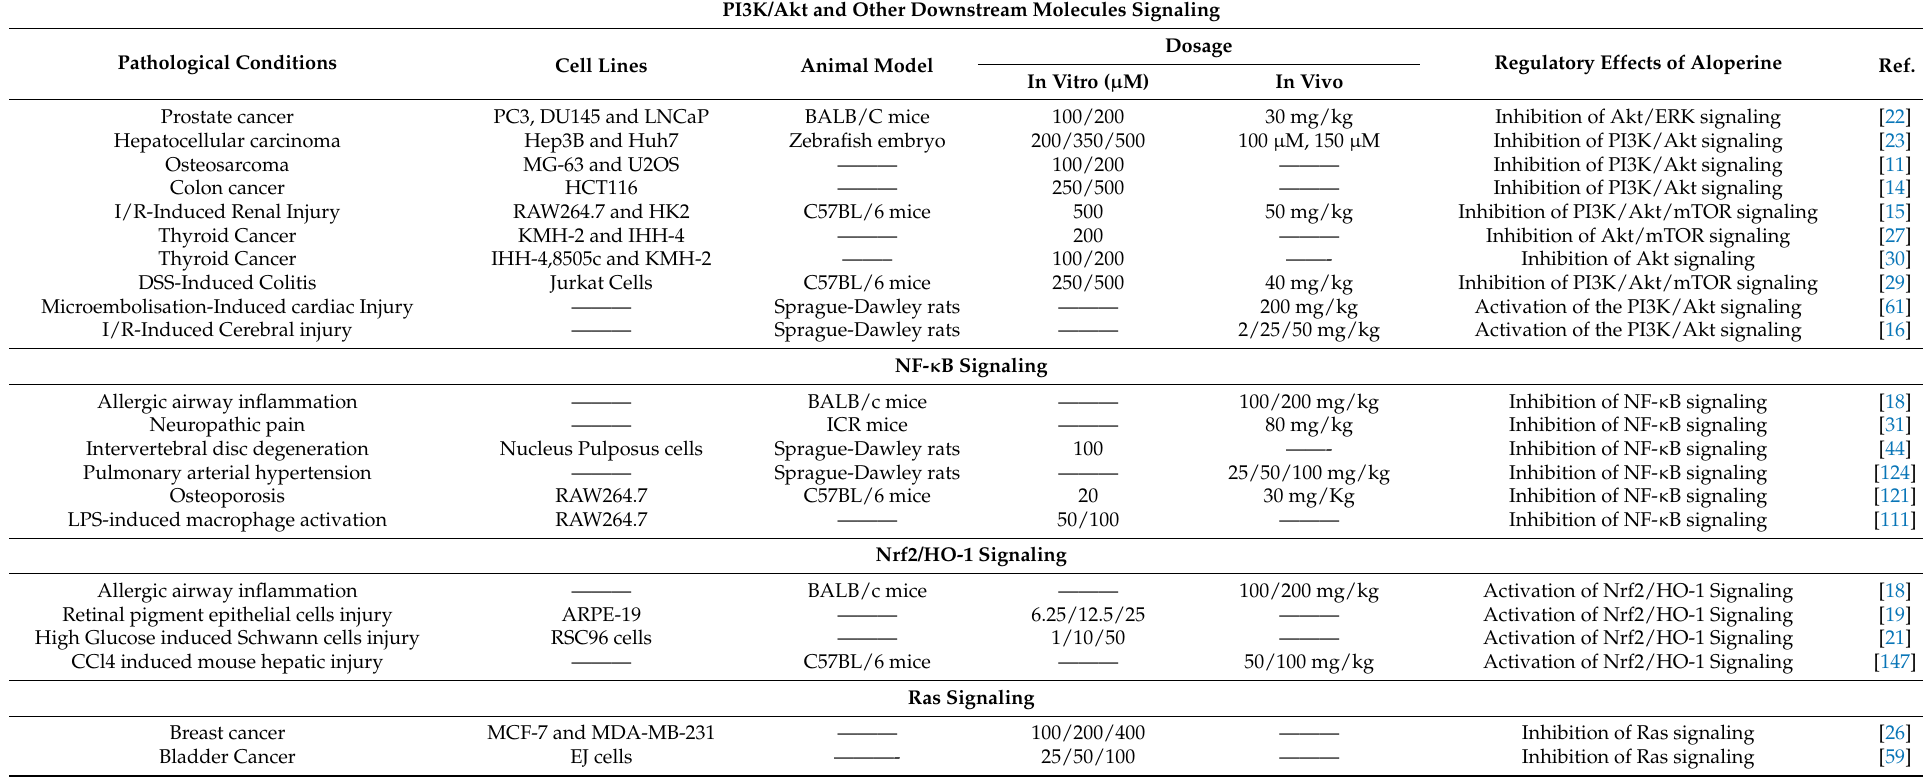
Table 2. Aloperine mediated modulations in signaling